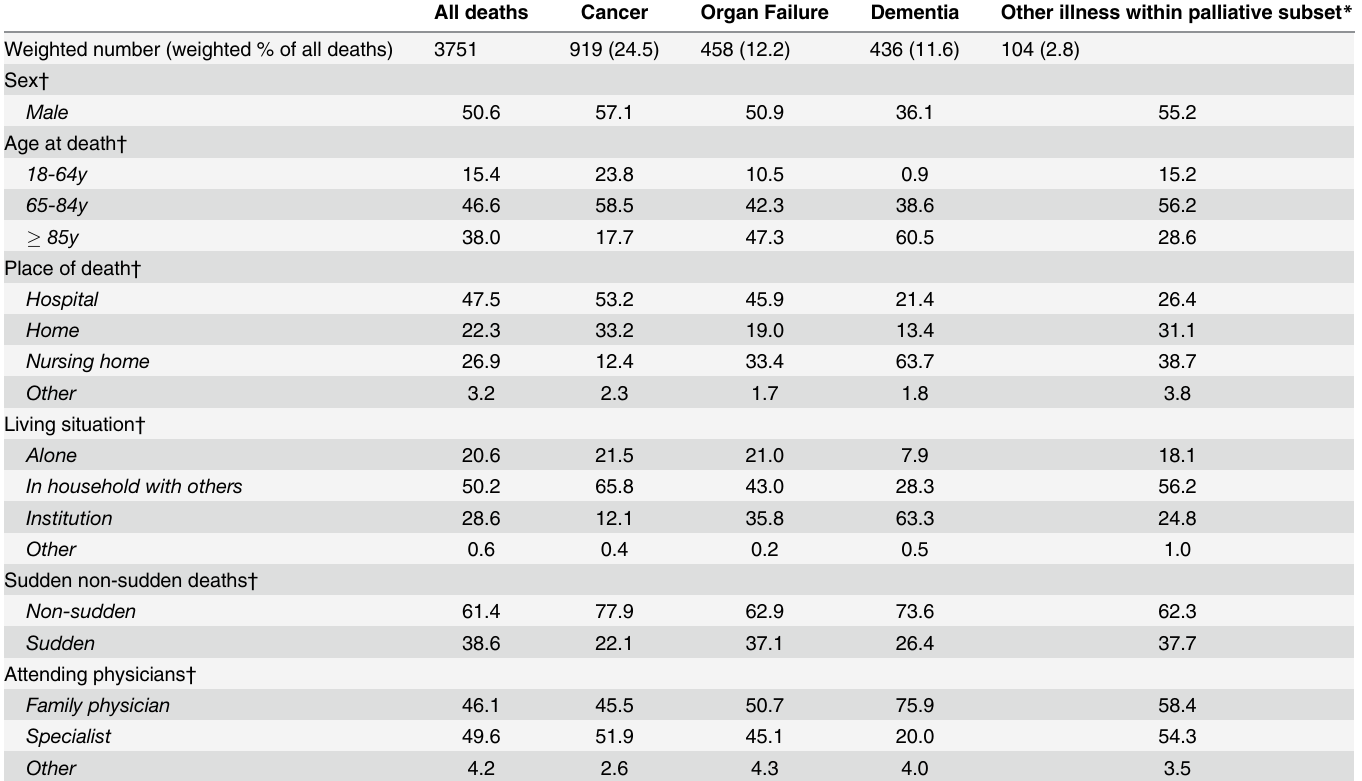
Table 1. Characteristics of all deaths and of illness groups considered as indicators for potential benefit of palliative care use (weighted %). All